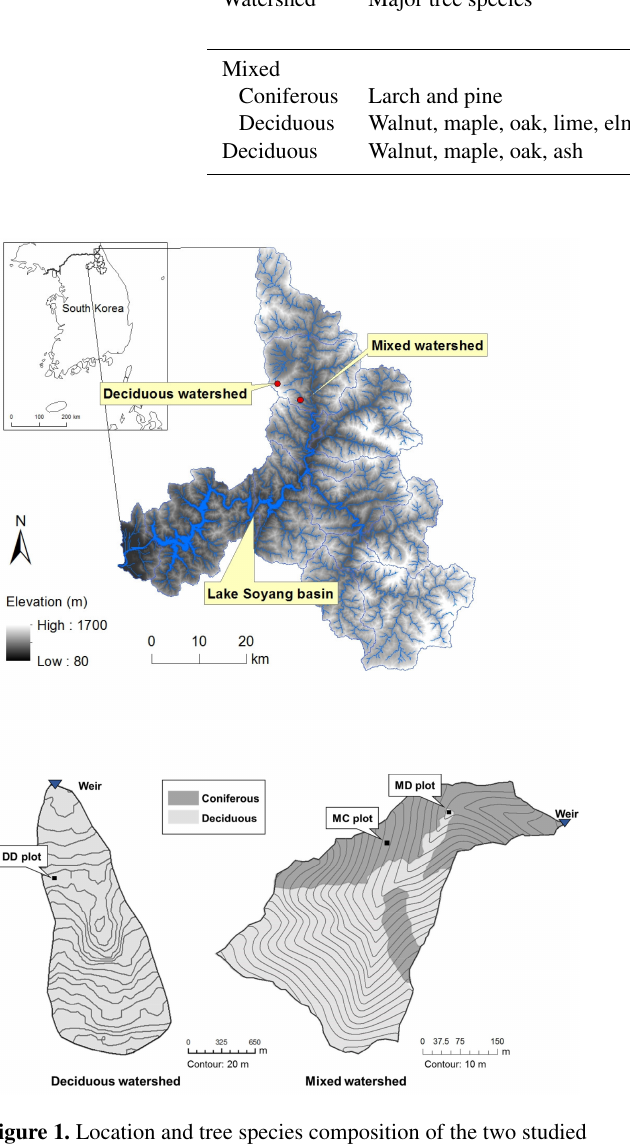
Figure 1. Location and tree species composition of the two studied forested watersheds. Lake Soyang map was modified from Jung et al.